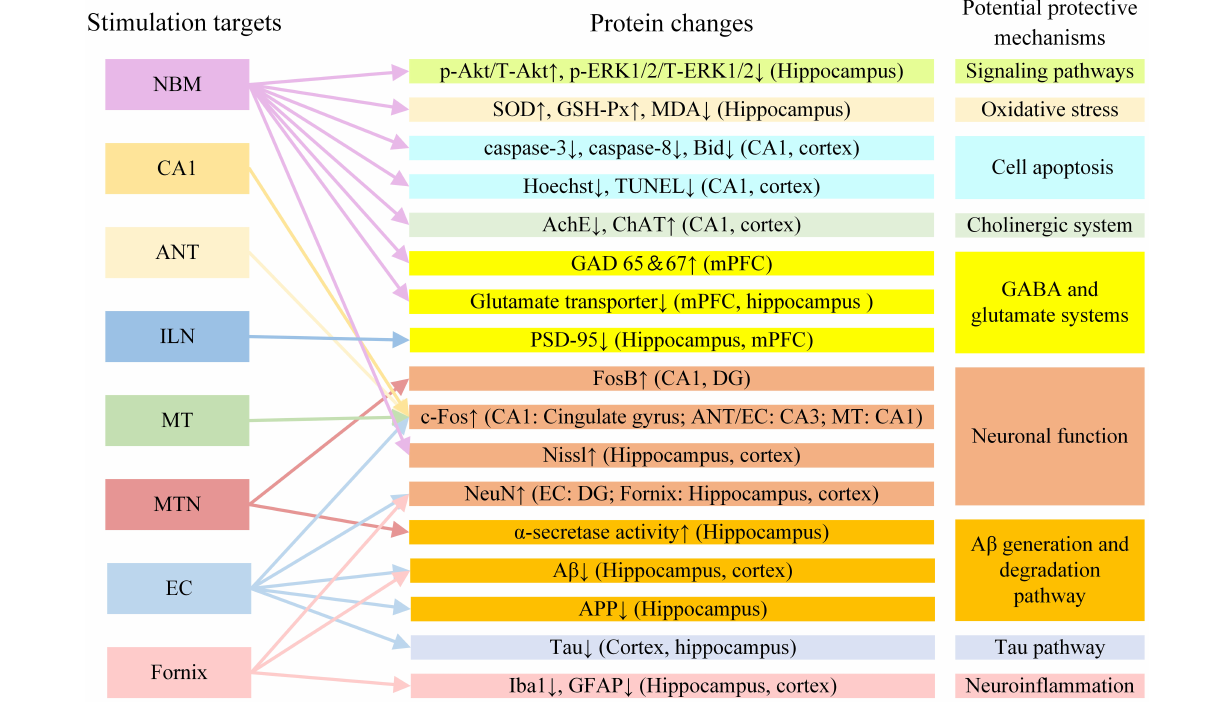
Frontiers in Aging Neuroscience |